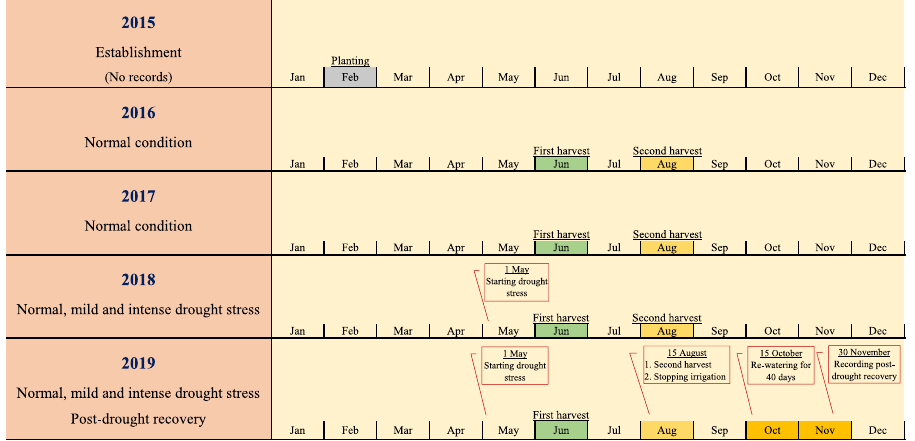
Figure 5. Timing and duration of activities (planting, harvesting and post-drought recovery evaluations) in seven grass species.